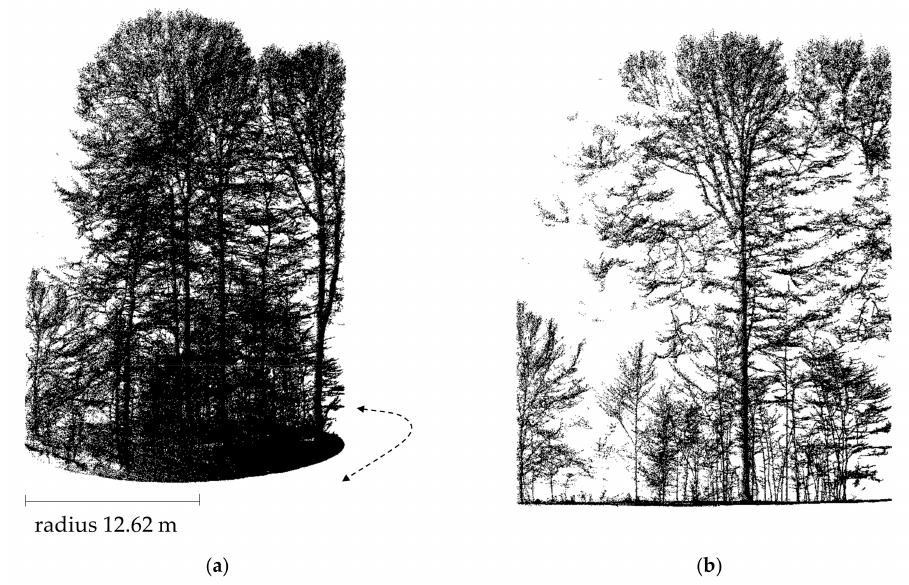
Figure 4. ( a ) Leaf-off MLS point cloud of sample plot 2. The dotted line with arrows indicates the MLS trajectory. ( b ) 3 m wide profile perpendicular to the scan trajectory of the MLS